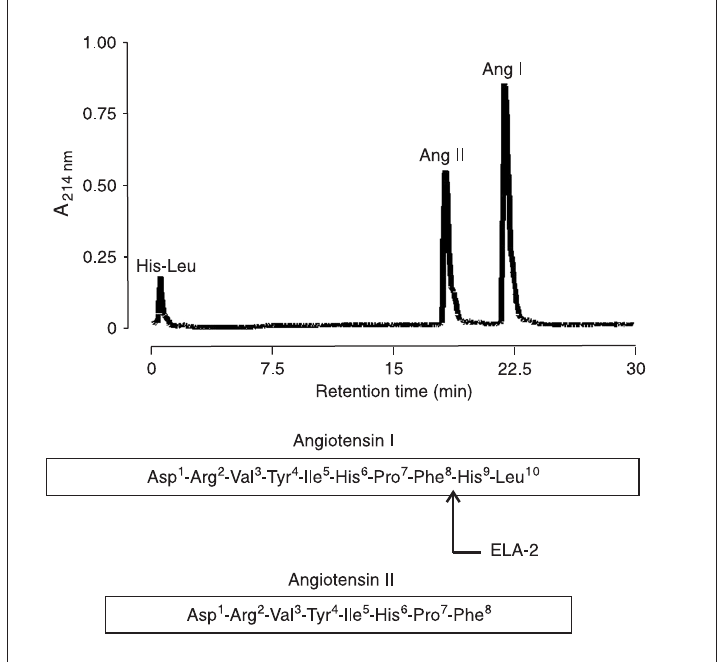
Figure 2. Hydrolysis of angiotensin I (Ang I) by the action of Ang II-forming en- zyme purified from rat. Ang I (10 nmol) was incubated with 30 μg elastase-2 (ELA-2) enzyme for 30 min at 37°C. The products of hydrolysis were separated by reversed-phase HPLC with an acetonitrile